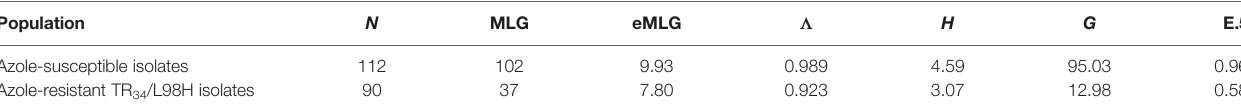
TABLE 2 | Genotypic richness, diversity, and evenness information for azole-susceptible and azole-resistant TR 34 /L98H isolates. Population